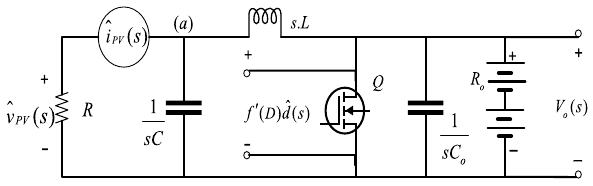
Figure 5. Small signal model of PV power converter